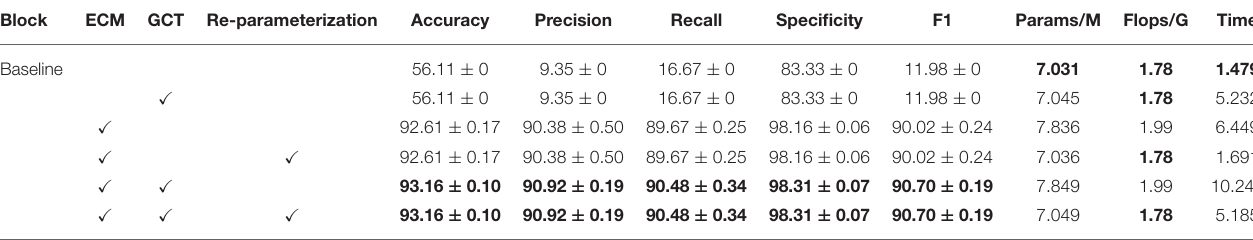
TABLE 7 | Results of selecting block.